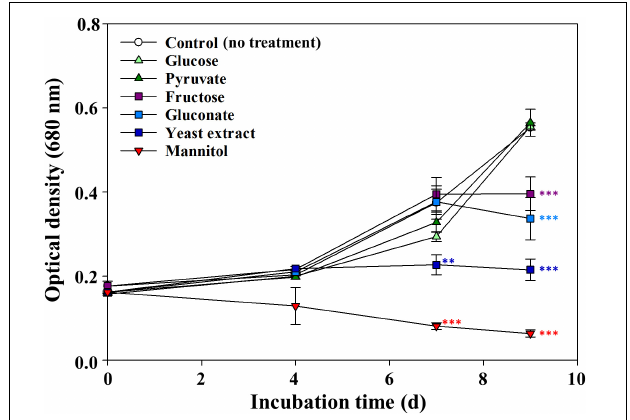
FIGURE 1 | Effects of various organic compounds on the growth of Microcystis aeruginosa NIES-298. After adding organic compounds (50 µ M), the cultures were incubated at 25 ◦ C under 40 µ mol photons m − 2 · s − 1 with a 12 h/12 h light/dark cycle. Data are indicated as mean values ± standard deviations. Statistical significances depending on organic compounds were calculated compared to the control group (no treatment) and their significant differences were indicated with different colors. ∗∗ p < 0.01; ∗∗∗ p < 0.001.